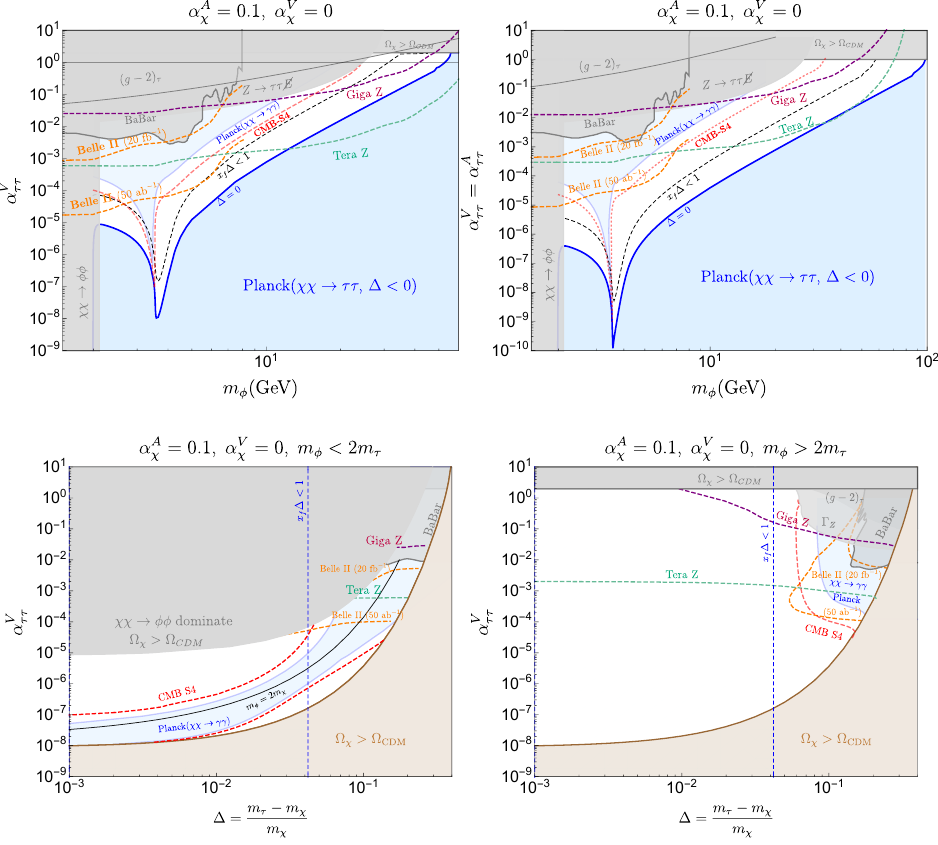
Figure 3 . Theoretical and experimental constraints on Forbidden DM annihilations into τ + τ − . We show constraints from searches at BaBar for e + e − → φγ [75, 83, 84], searches at LEP for Z → ¯ ττ +MET [65, 75], the LEP measurement of the Z width [85], the tau anomalous magnetic moment [82], and Planck constraints on DM annihilations [56]. We include projections for CMB- S4 [72], Belle II [83, 86] and future Z -factories [87–91]. In the upper (lower) row, we choose ∆ ( m φ ) to match the observed relic density in the white region. We shade in gray the region where ordinary annihilations to a pair of mediators set the relic density. In the brown area Forbidden DM has too large of an